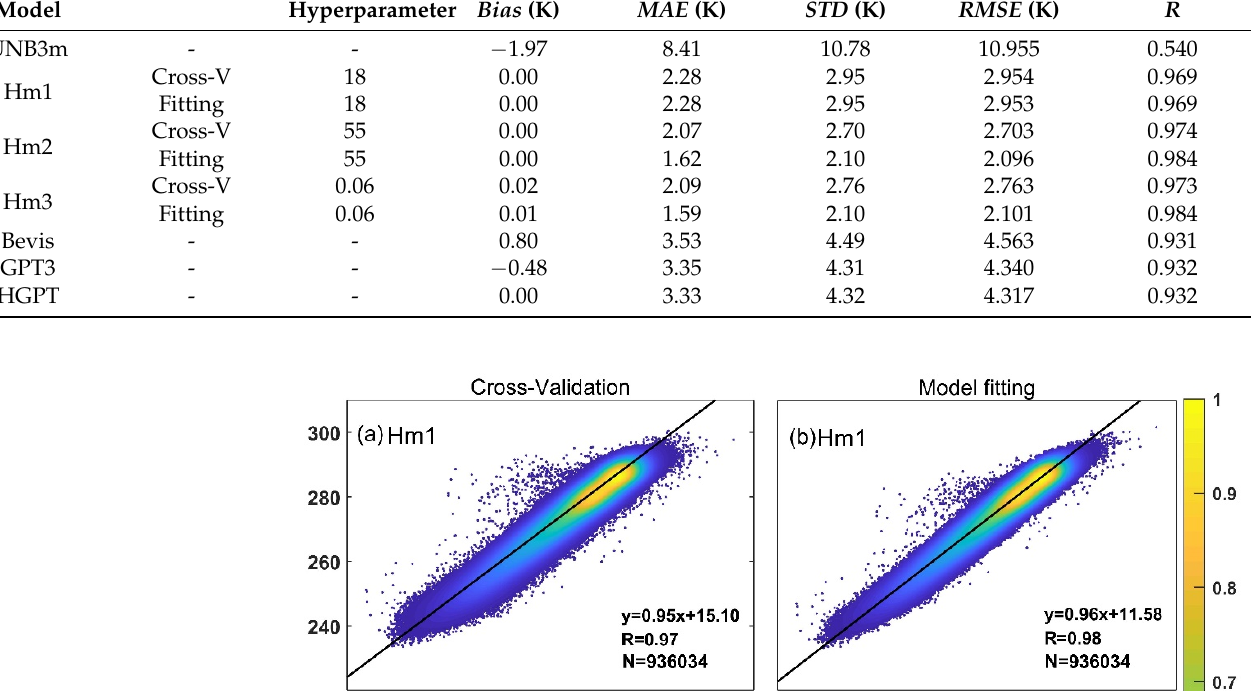
Table 2. Relative radiosonde data, the accuracy evaluation results of different models. Model